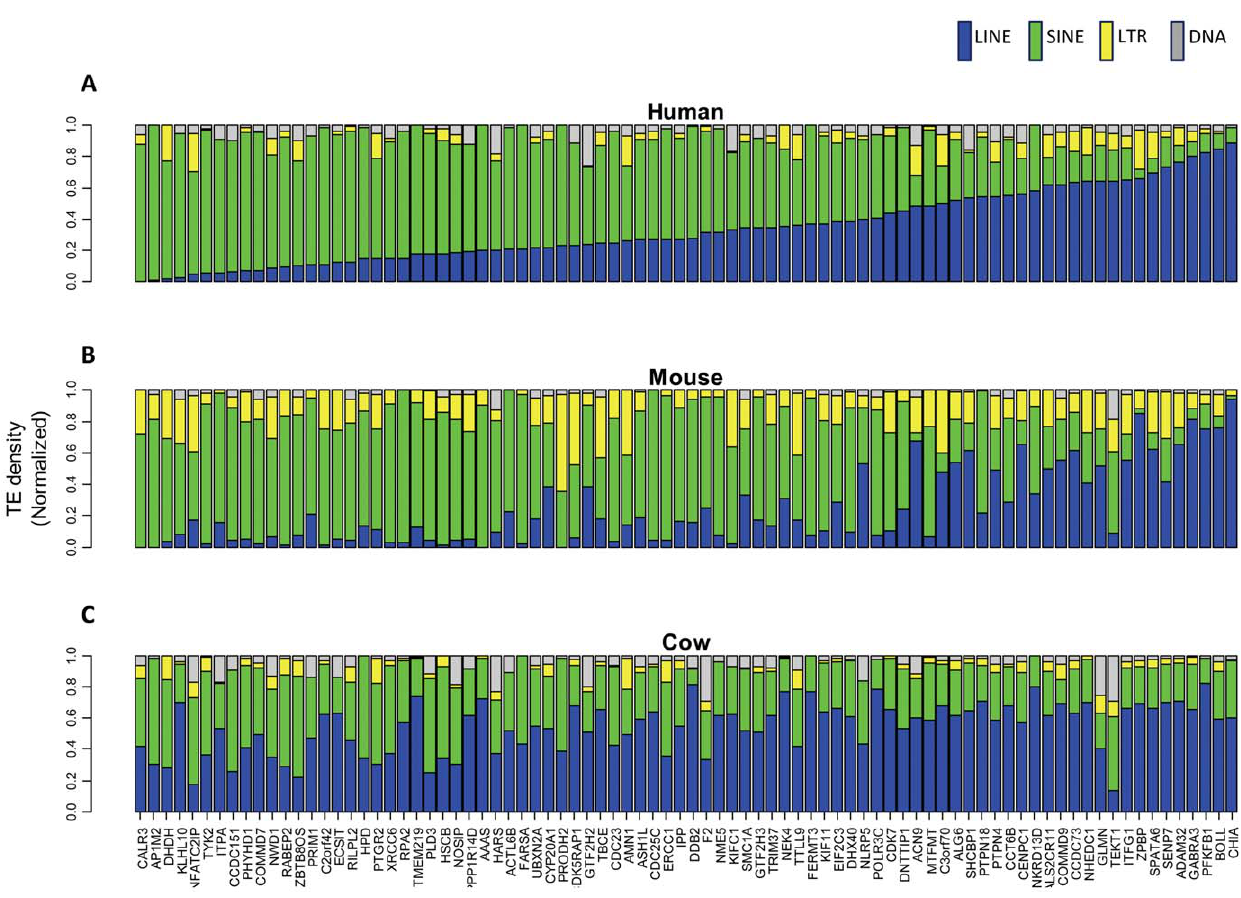
Figure 1. TE composition patterns of SUO genes. Patterns for human, mouse and cow are shown in (A), (B) and (C), respectively. Relative proportions taken by different TE classes for each SUO gene are shown as a stacked bar, with the color scheme for the four major TE classes indicated at the top. Genes are arranged in the same order for all three species. Gene names at the bottom are from the annotation of human RefSeq genes.